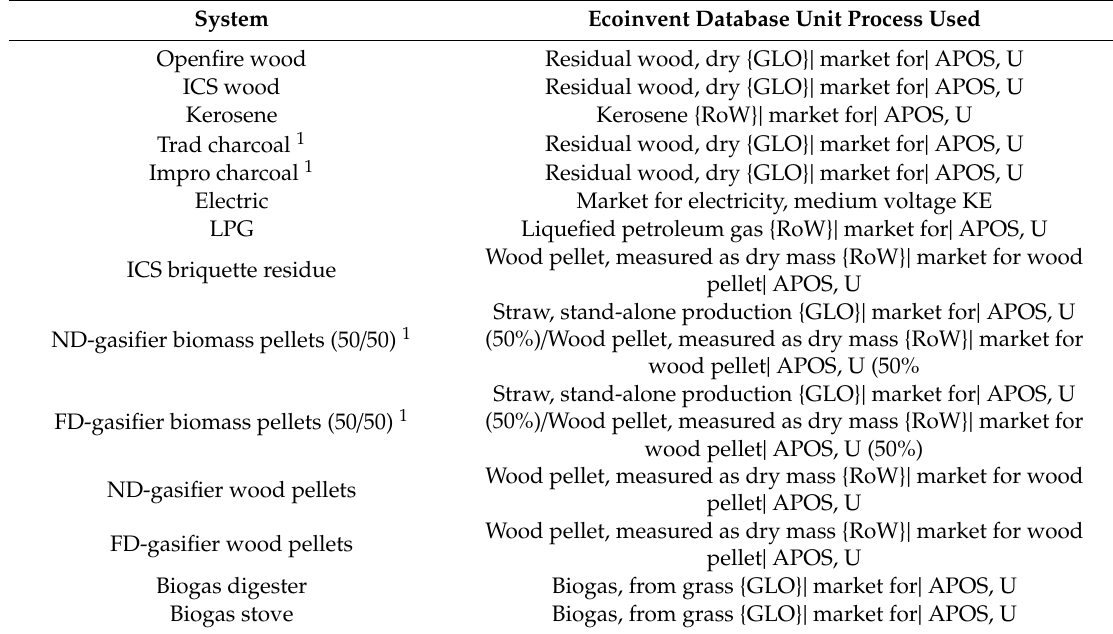
Table A1. Dataset used from the Ecoinvent database related to the LCA study in every fuel.